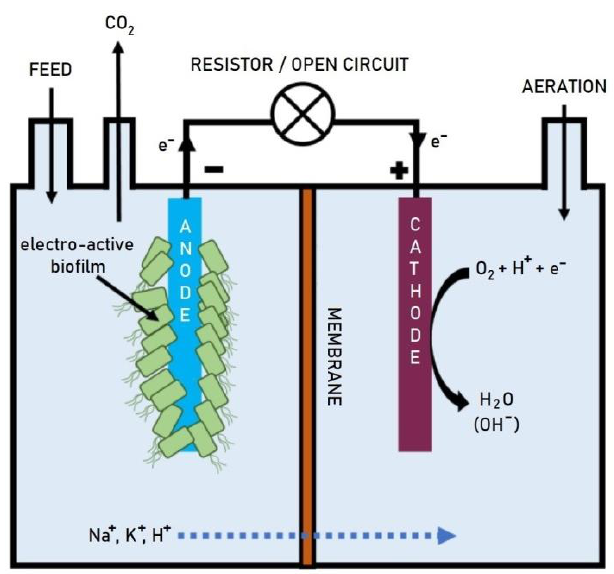
Figure 5. MFC. Figure 5.